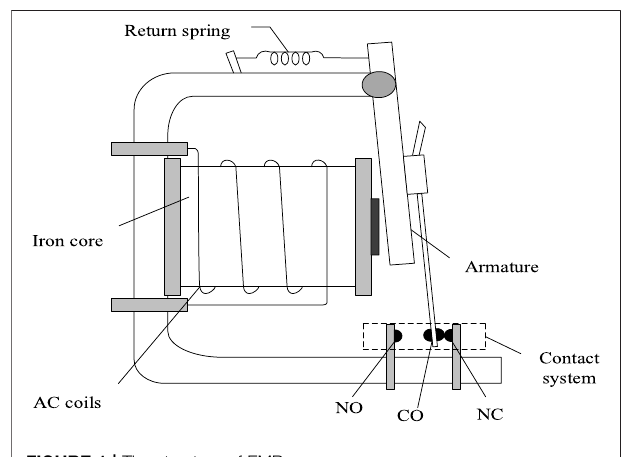
FIGURE 1 | The structure of